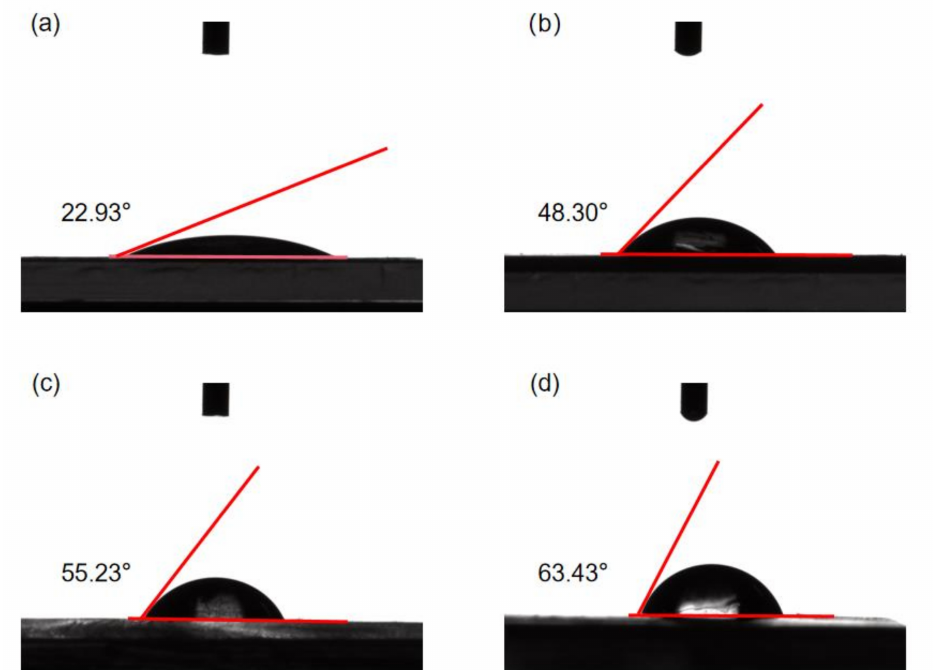
Figure 10. Photographs of contact angle on polyacrylate latex films prepared with ( a ) SDS (1 wt%), ( b ) Laponte-2C18 (3 wt%), ( c ) hectorite-2C18-V (3 wt%), ( d ) hectorite-2C18-2V (3